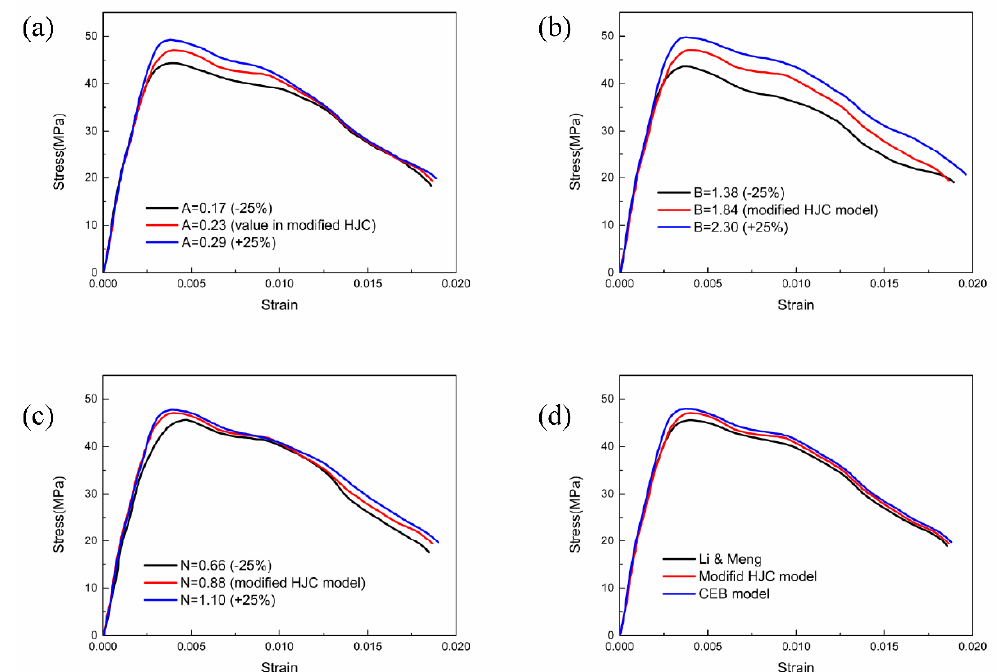
Figure 14. E ff ect of strength parameters on the stress–strain curve: ( a ) e ff ect of parameter A on the Figure 14. Effect of strength parameters on the stress–strain curve: ( a ) effect of parameter A on the stress–strain curve, ( b ) e ff ect of parameter B on the stress–strain curve, ( c ) e ff ect of parameter N on the stress–strain curve, ( b ) effect of parameter B on the stress–strain curve, ( c ) effect of parameter N on stress–strain curve, ( d ) e ff ect of parameter C on the stress–strain the stress–strain curve, ( d ) effect of parameter C on the stress–strain curve.